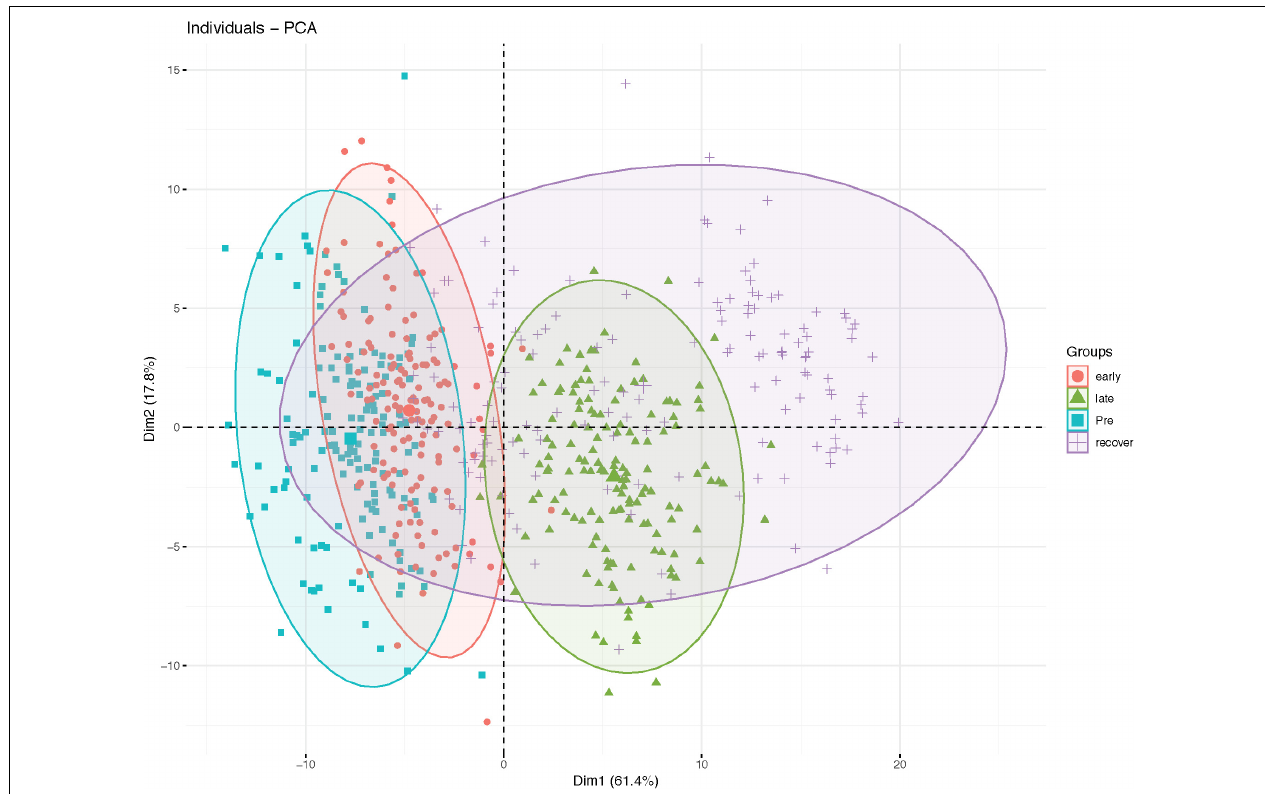
FIGURE 1 | Principal component analysis plot of RIL population during water-stress progression.